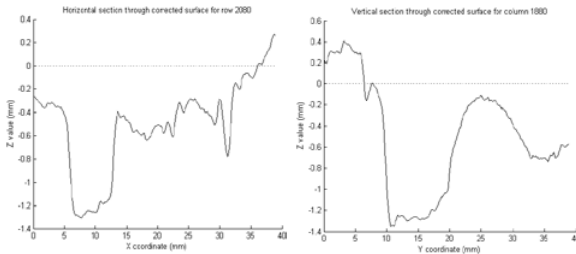
Figure 16. (left) Horizontal and (right) vertical cross-sections after correction of the normals.